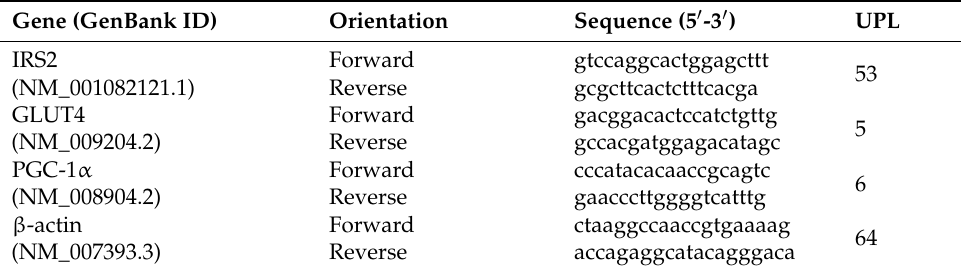
Table 1. Real-time PCR primers used in this